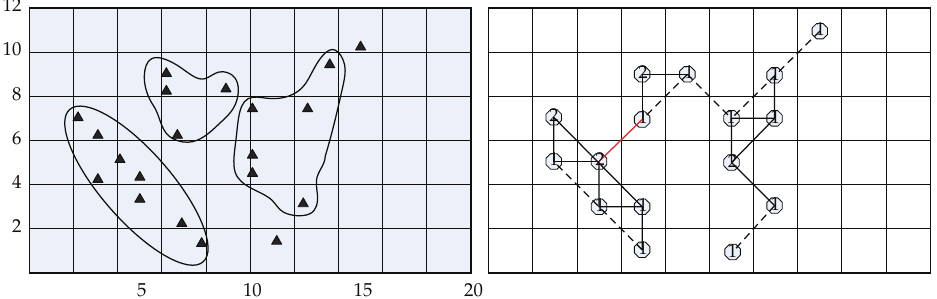
Figure 8: Data example one with graph generated with grid interval 2. Parameters p 0 (cid:8) 1 and ω 0 (cid:8) 1.